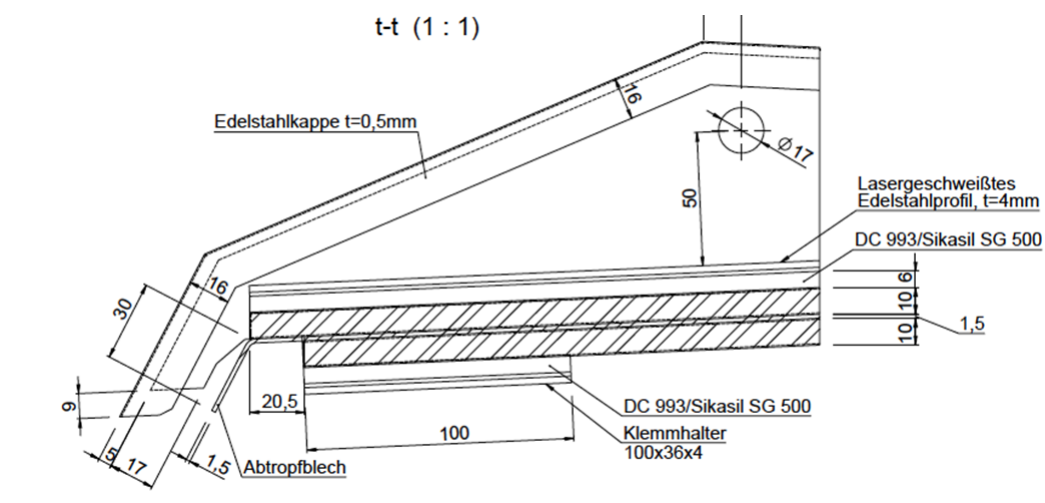
Fig. 4 Drip plate at the bottom